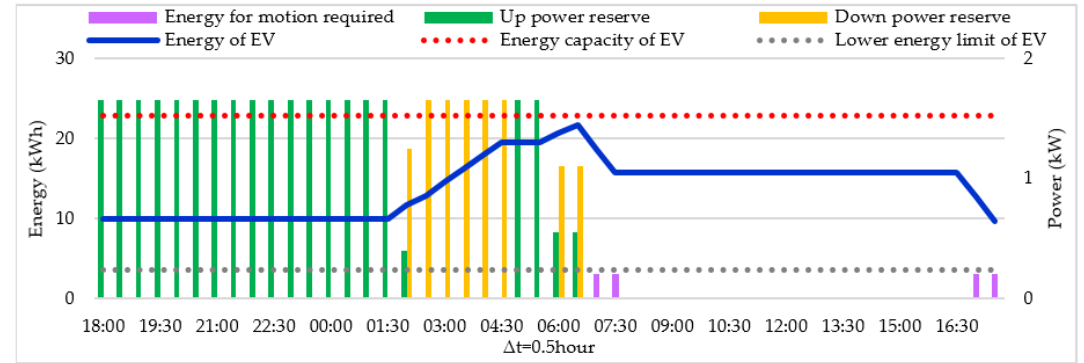
Figure 10. Charging behavior and o ff ers of reserve services of EV # 4 on weekend with ∆ t = 0.5 h.